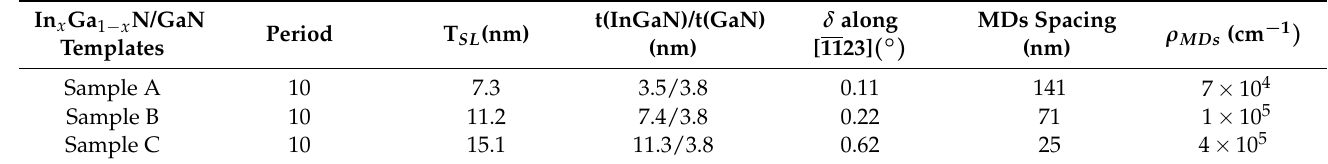
Figure 3. Reciprocal space maps of the (1122) plane of superlattice templates along the [1100] and the [1123] directions: ( a , b ) Sample A; ( c , d ) Sample B; ( e , f ) Sample C. Table 1. The parameters of the superlattice templates of Sample A, Sample B and Sample